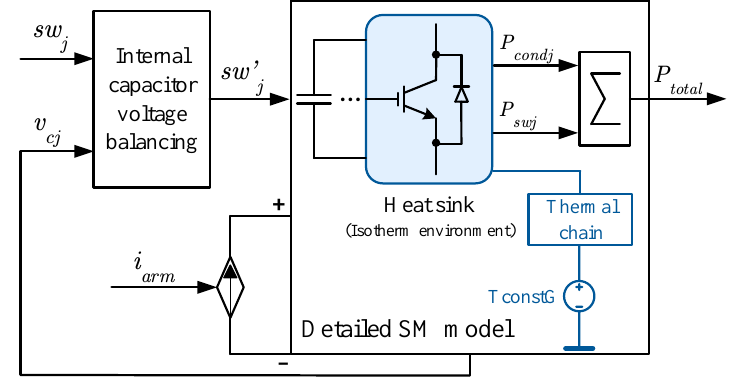
Figure 16. Thermal model of the IGBT